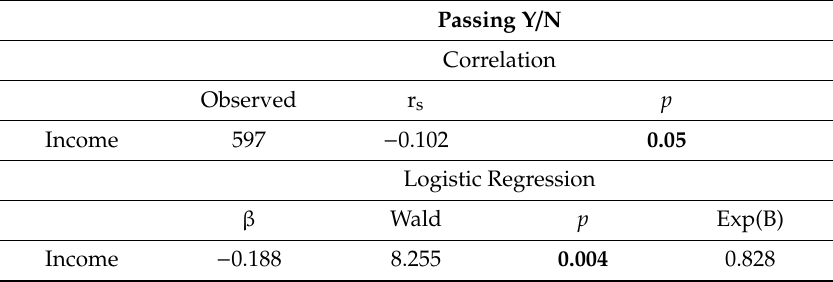
Table 6. Relationship between Income and Passing.